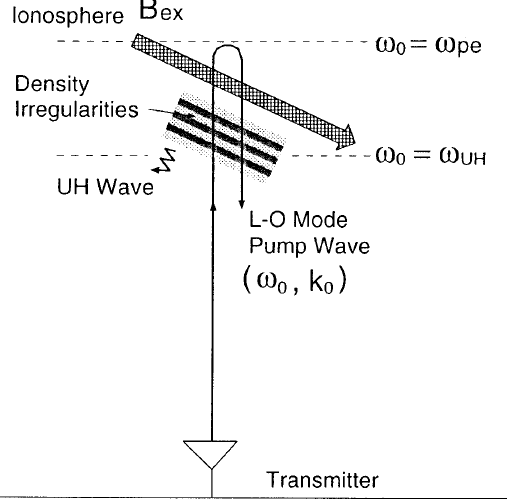
Fig. 1. Schematic illustration of the ionospheric heating experiment. The pump wave is a L-O mode wave, which is converted to an upper hybrid wave though the density irregularities along the